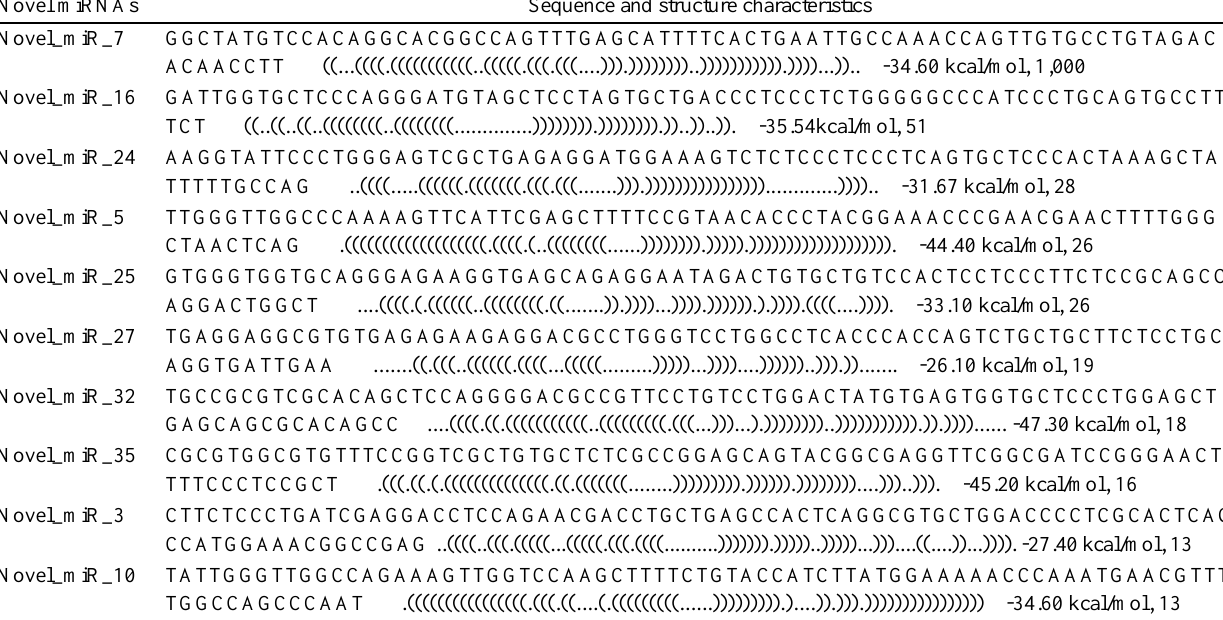
Table 2. Sequences and predicted stem-loop structure characteristics for the 10 most abundant candidate miRNAs Novel miRNAs Sequence and structure characteristics